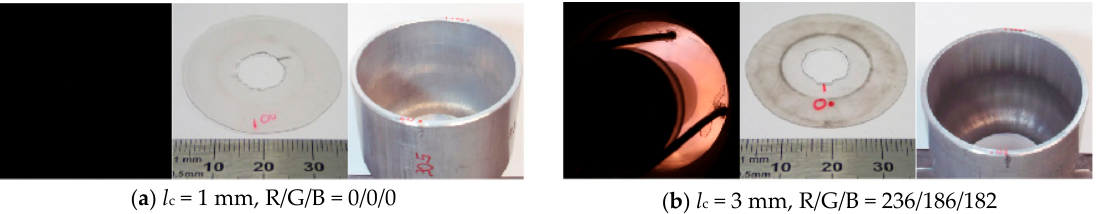
Figure 13. Long time exposures of the process glare,first plastic disc and flyer tube after MPW experiments at the Bmax setup ( p = 0.1 mbar, α = 0°, g = 1.5 mm, E = 4.5 kJ, I max = 365 kA, Ø coil = 41 mm, w c = 10 mm, l w = 6 mm): ( a ) l c = 1 mm ( b ) l c = 3 mm.